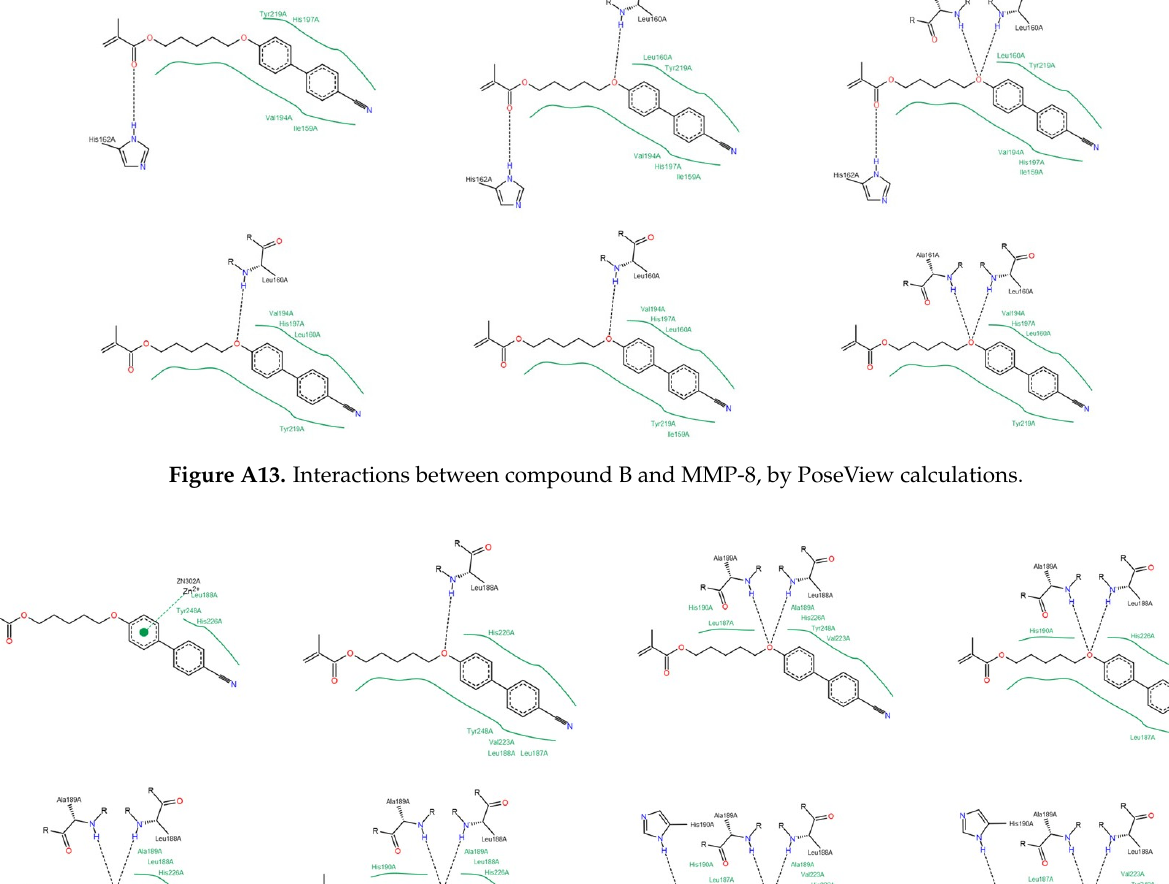
Figure A12. Interactions between compound B and MMP-2, by PoseView calculations.